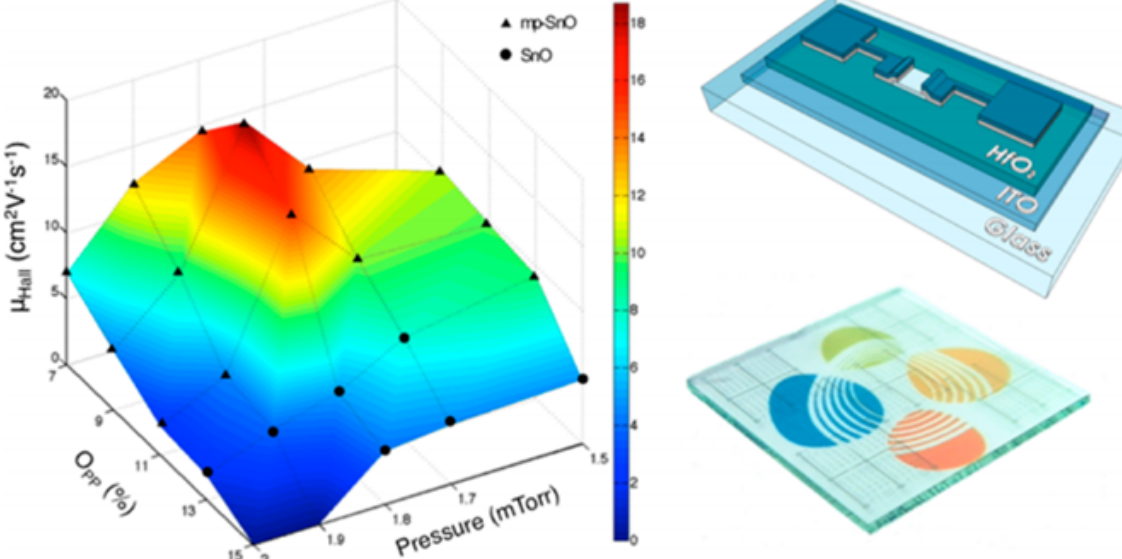
Figure 11: Phase map for nanoscale physical vapor deposition of SnO [66]